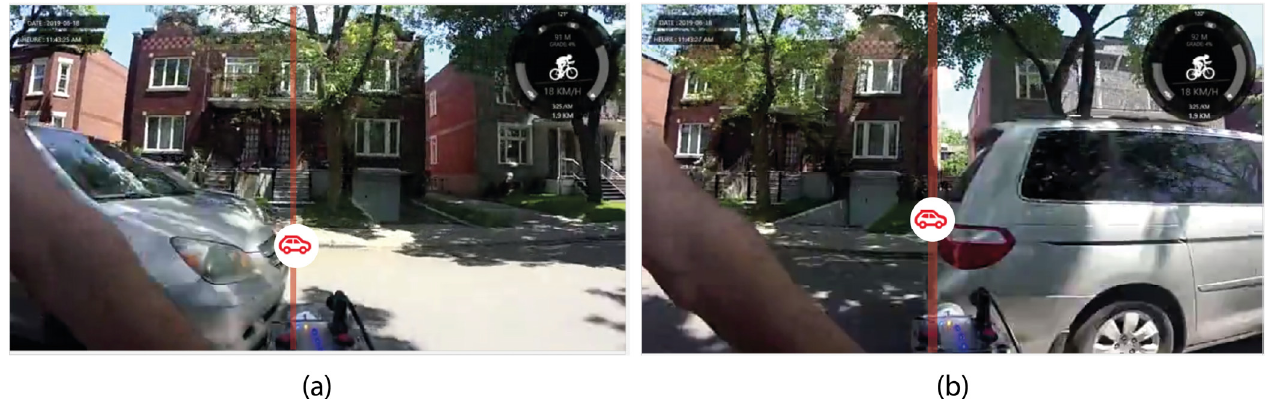
Figure 5. Characterization of a lateral passing on Vifeco. ( a ) beginning of passing aligned with the device for distance measurement; ( b ) end of passing. device for distance measurement; ( b ) end of